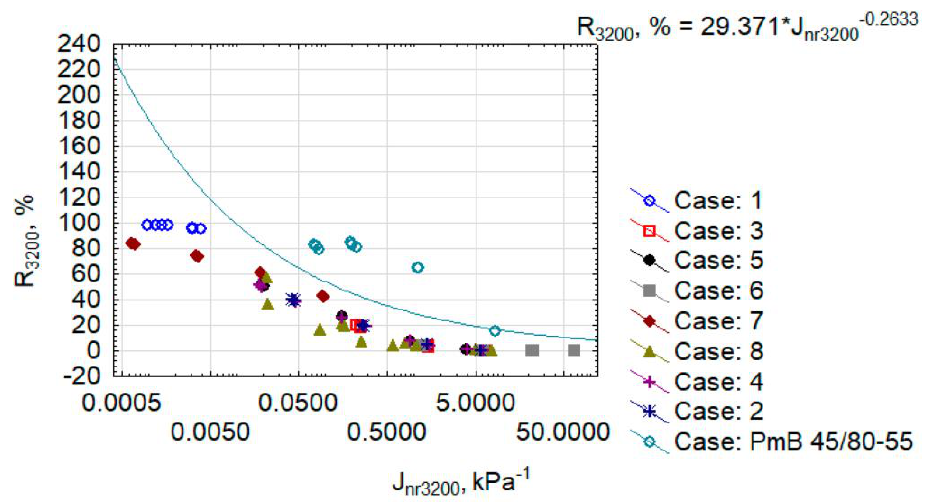
Figure 10. Creep compliance vs recovery.